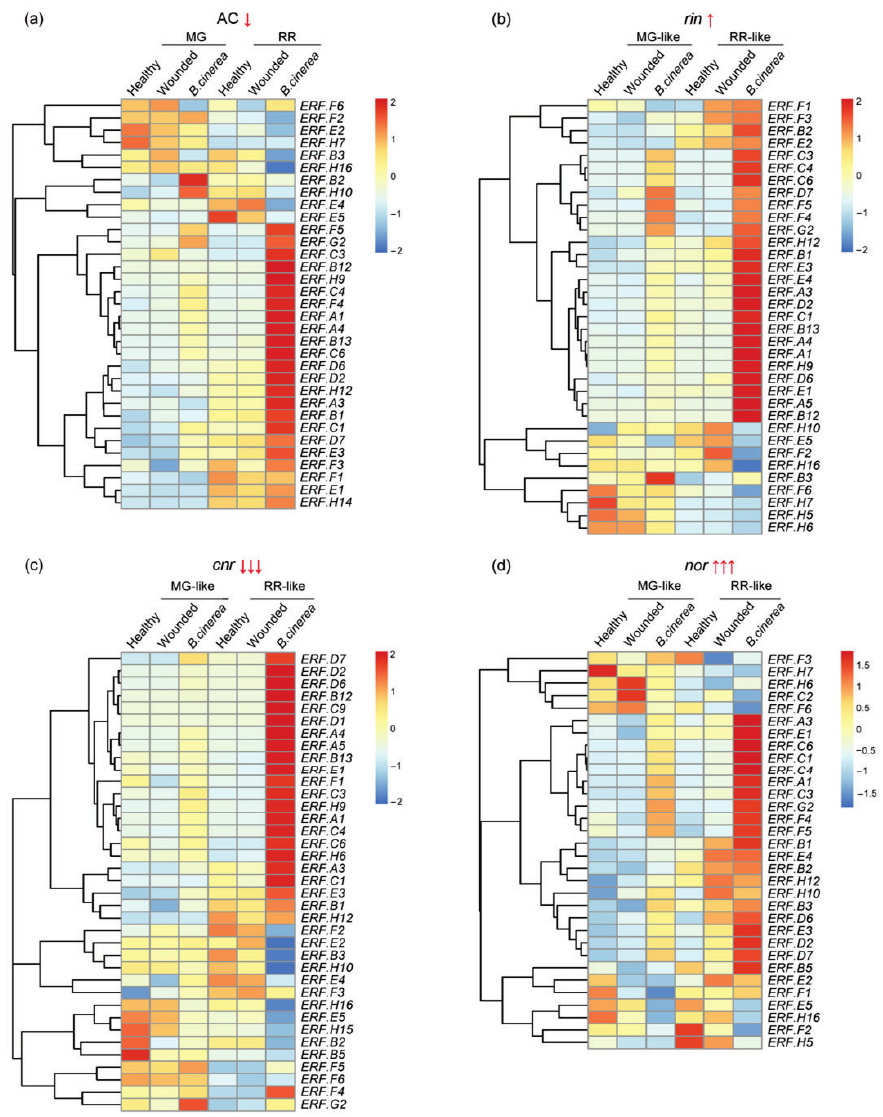
Figure 3. Gene expression pattern of ERFs in tomato ( a ) wildtype ( Ailsa Craig , AC) and ripening mutant ( b ) rin , ( c ) cnr and ( d ) nor in healthy fruit and fruit infected with B. cinerea or uninfected (wounded). Wildtype tomato fruits were picked at mature green (MG) and red ripe (RR) stages; the ripening mutant fruits including Cnr , nor , rin were picked at MG-like and RR-like stages, all of which included healthy (healthy, neither wounded nor infected), wounded (wounded but did not infected) and B. cinerea (wounded plus infected with B. cinerea ) fruits. All tomato fruit were sampled at 1 day post-inoculation (dpi) and fruit pericarp and epidermal tissue, excluding seeds, of the blossom end halves of healthy, wounded, and infected fruit were collected. Raw transcriptome data (accession number: GSE148217) were downloaded from the NCBI database and transformed to FPKM using hisat2 tools. The FPKM values were normalized by row and displayed with color ranging from blue (low) to red (high). Genes with FPKM values in all the tissues below 10 were considered as low-level transcripts and are not displayed in the heatmap. A single down arrow sign “ (cid:280) ” indicates medium sensitivity to B. cinerea infection, triple down arrow “ (cid:280)(cid:280)(cid:280) ” indicates extremely sensitive, the up arrow sign of “ (cid:278) ” represents slightly resistant, and the triple up arrow sign “ (cid:278)(cid:278)(cid:278) ” represents extremely resistant. These 33 genes have different pathogen-response-related patterns; 16 genes ( ERF.A1 , A4 , B2 , B12 , B13 , C1 , C3 , C4 , C6 , D2 , D6 , D7 , F4 , F5 , G2 , H9 ) display an obvious increase (fold change above 2.0) in their expression after B. cinerea inoculation compared